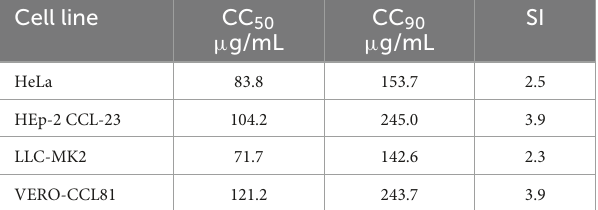
TABLE 3 Effect of N -(butylcarbamothioyl) benzamide (BTU-01) on the viability of different cell lines, demonstrated by the cytotoxic concentrations (CC 50 , CC 90 ), and the selectivity index (SI).